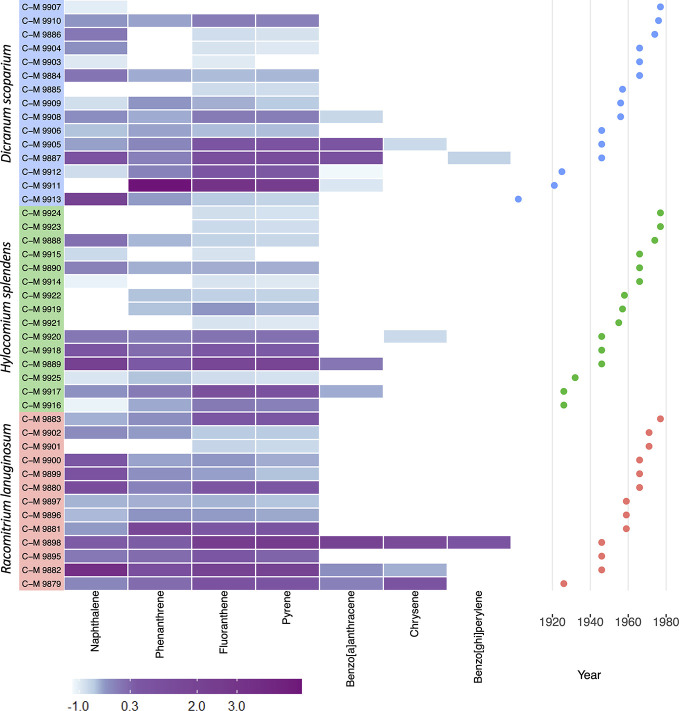
Heat map of detected PAHs and across all samples divided by species. The concentrations are normalized and assigned a score (column Z-score) and corresponding color, with blue being the lowest values and purple the highest amounts of compound detected in the sample. The Z-score is calculated based on the number of standard deviations that the value of the sample is above or below the mean.